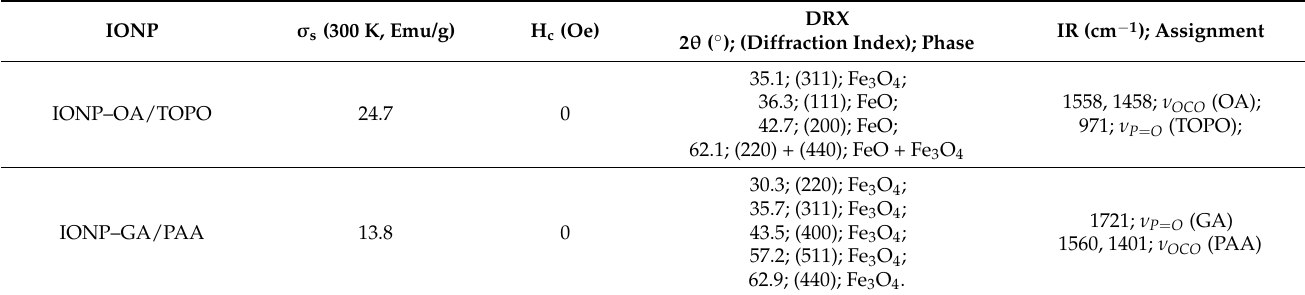
Table 1. Characterization results of the IONP–OA/TOPO and IONP–GA/PAA obtained by Vibrating Sample Magnetometry (VSM), X-ray powder diffractometry (XRD,) and Fourier-transform infrared spectroscopy (FTIR).